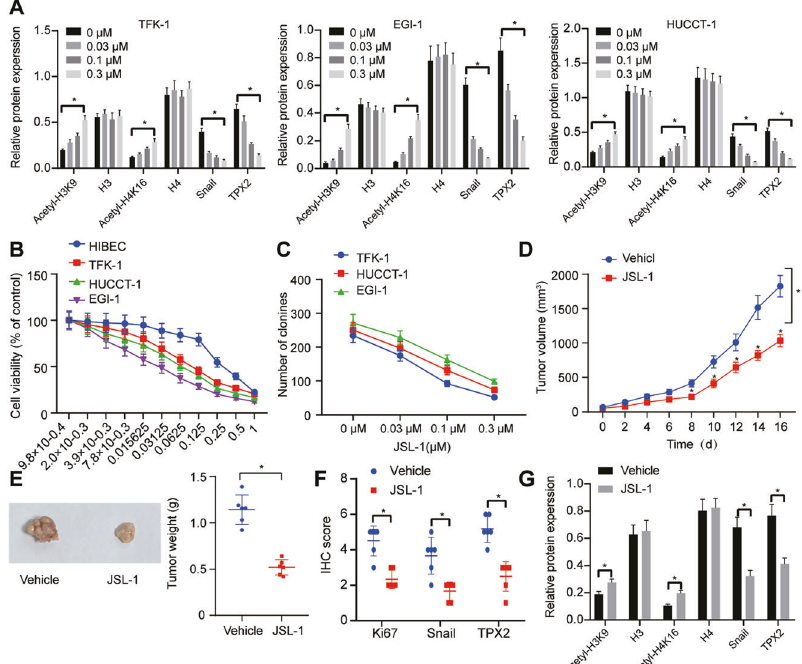
Fig. 7 JSL-1 impedes the proliferation of CC cells and tumorigenesis via repression of Snail/TPX2. A Acetylation level of H3K9 and H4K16 and expression of Snail and TPX2 proteins in TFK-1 cells upon JSL-1 treatment. B Viability of TFK-1 cells upon JSL-1 treatment at different doses detected by MTT assay. C Number of colonies in TFK-1 cells following JSL-1 treatment assessed by colony formation assay. D Tumor volume of nude mice upon JSL-1 treatment. E Tumor weight of nude mice upon JSL-1 treatment. F Ki67-positive cells and positive Snail and TPX2 protein expression in tumor tissues of nude mice treated with JSL-1 detected by immunohistochemistry. G The expression of Snail and TPX2 proteins and acetylation level of H3K9 and H4K16 in tumor tissues of nude mice after JSL-1 treatment measured by Western blot analysis. * p < 0.05. In panel ( A ), data were compared by one-way ANOVA with Tukey ’ s post hoc test. In panels ( E – G ), data were compared using unpaired t -test. In panels ( B – D ), data were compared using repeated measures ANOVA with Bonferroni post hoc test. The cell experiment was independently repeated three times. n = 6 for animal